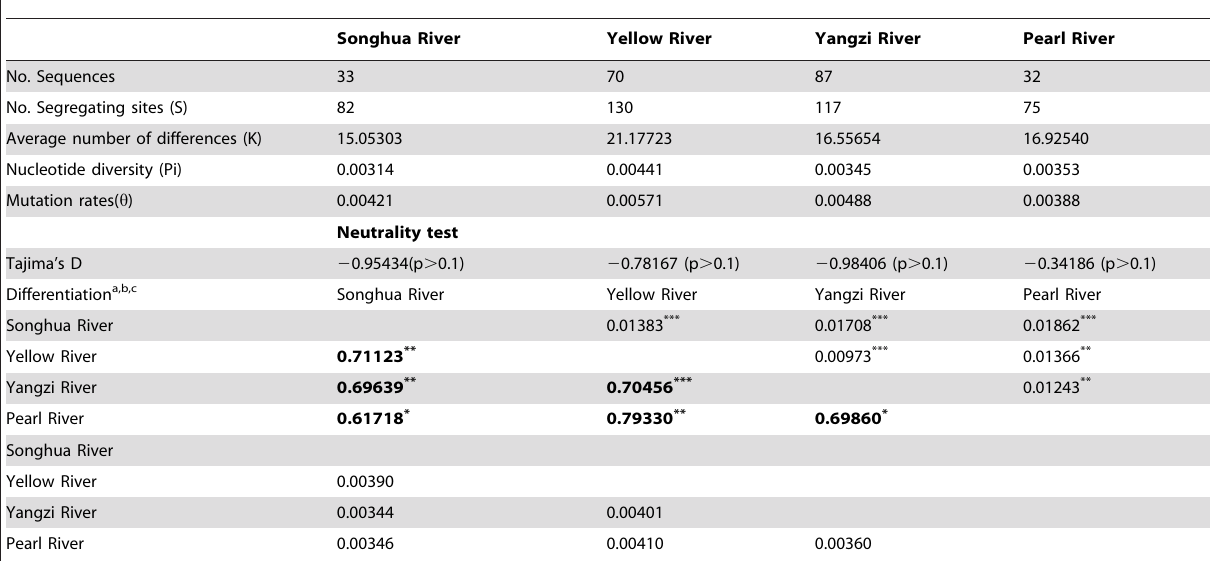
Table 5. Divergence and differentiation among water